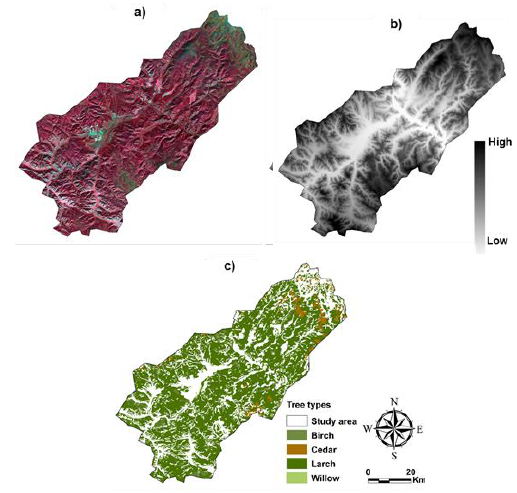
Figure 2. a) Landsat 8 surface reflectance image in false color, b) ASTER GDEM and c) Forest tree species reference map